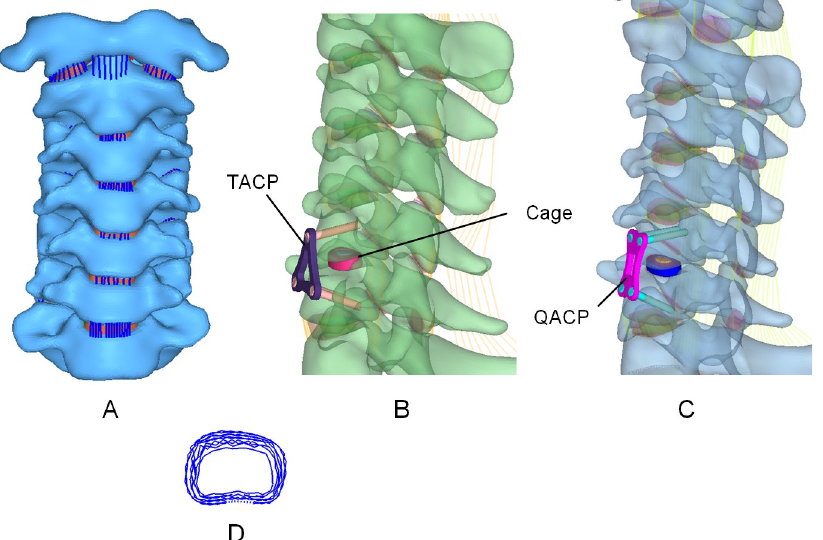
Fig 1. Intact cervical spine C1-C7 model and post-implantation model. (A) The intact C1-C7 cervical spine finite element model; (B) The model after TACP implantation; (C) The model after QACP implantation; (D) crescentic fibrous